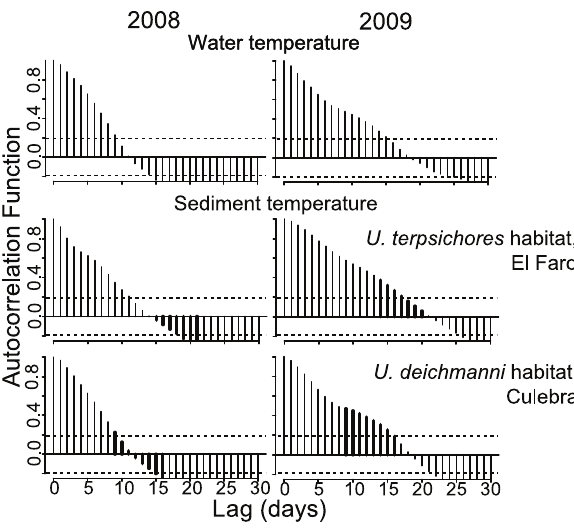
Figure 2. Temperature correlograms. Predictability in temperature during the upwelling season in both years expressed as the strength of the autocorrelation between the temperature on a given day and 1–30 days (lag) in the future. Water temperature (top row) was measured at 1 m depth in Culebra Bay. Sediment temperature was recorded at 20 cm depth in the habitat of each species at the coldest site for which we have data for both years (middle and bottom rows). Autocorrelation function values greater than the dashed horizontal line differ significantly from zero. Lags equivalent to the range of field measurements of incubation periods of both species during upwelling in 2009 are highlighted in bold ( Uca deichmanni : 9–16 days, U. terpsichores : 14–21 days, Kerr et al. 2012, note that incubation period data is not available for 2008, but would have been shorter on average based on the relationship between temperature and incubation period). Significant autocorrelation at lags equivalent to the incubation period indicates that water temperature is predictable at the scale of the period of incubation.